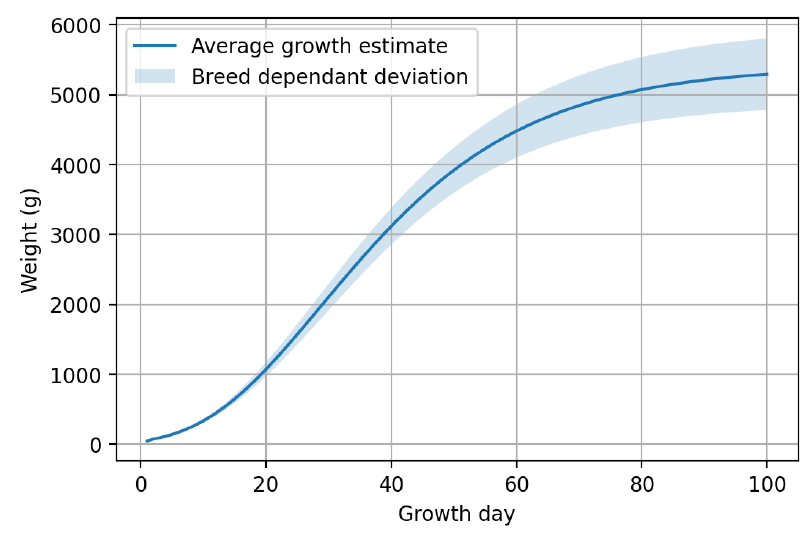
Figure 3 . Broiler average growth estimate per day in grams [13]